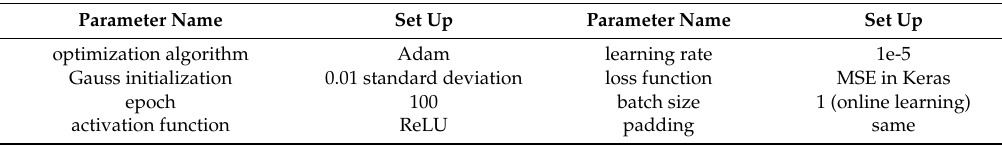
Table 1. Training parameter